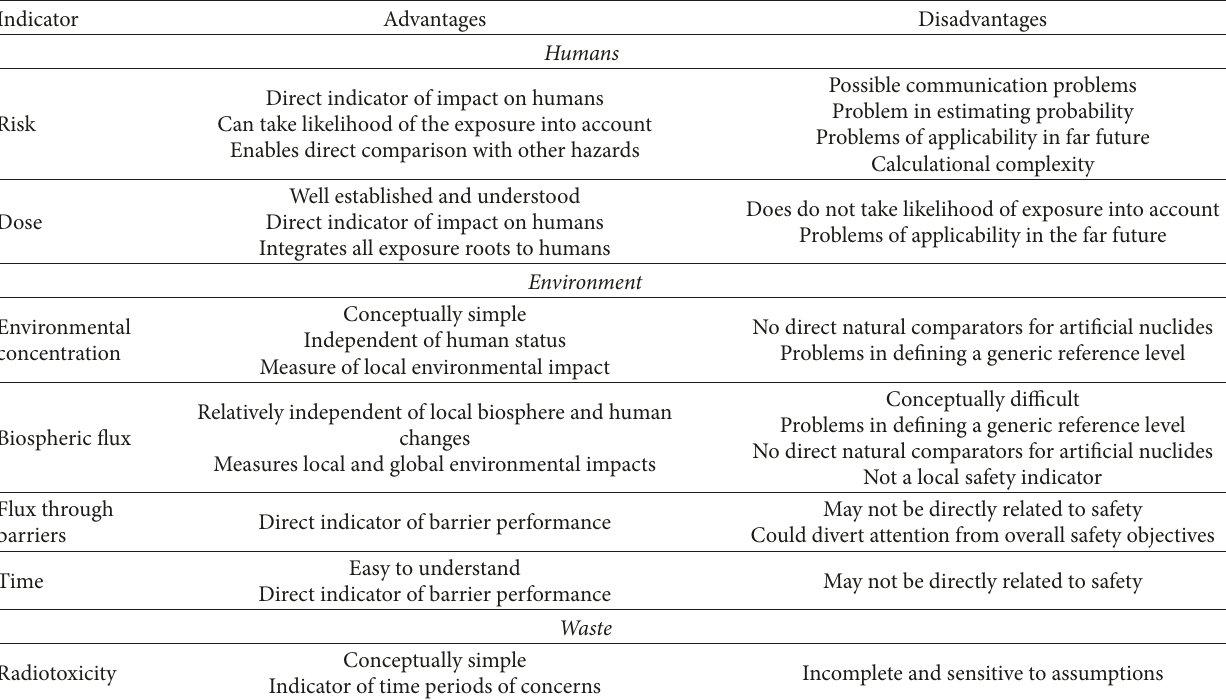
Table 3: Safety indicators survey